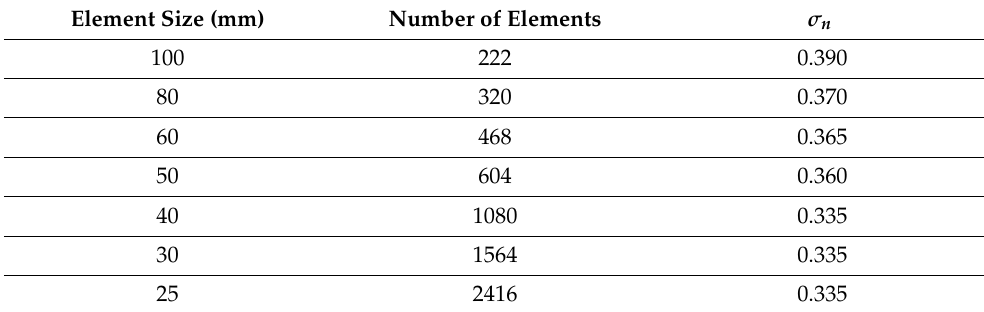
Table 7. Mesh convergence test for the stiffened perforated plate with t = 5 mm and Q = 2 q u /3. Element Size (mm) Number of Elements